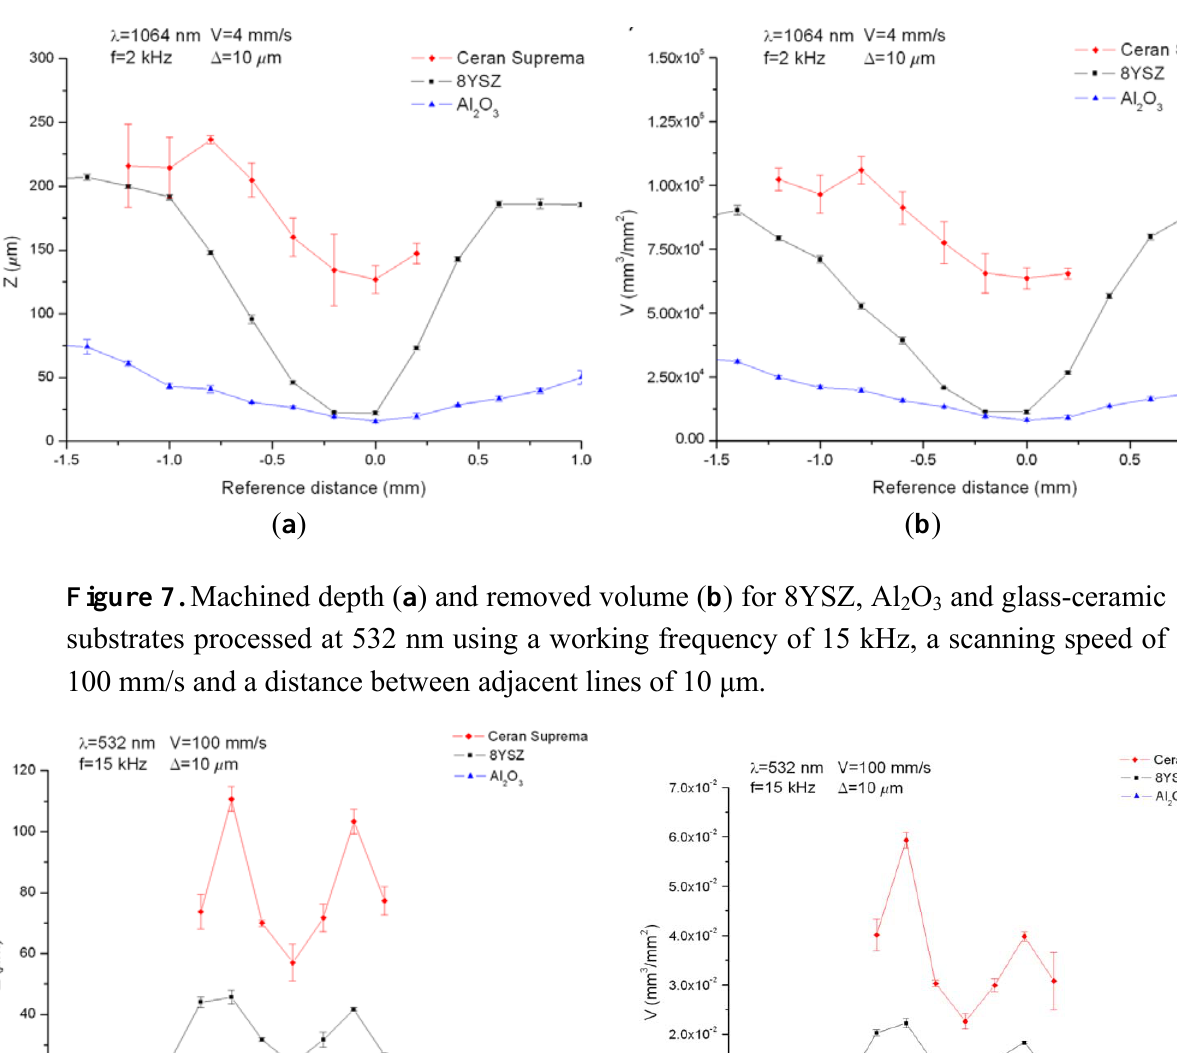
Figure 6. Machined depth ( a ) and removed volume ( b ) for 8YSZ, Al substrates processed at 1064 nm using a working frequency of 2 kHz, a scanning speed of 4 mm/s and a distance between adjacent lines of 10 μ m.